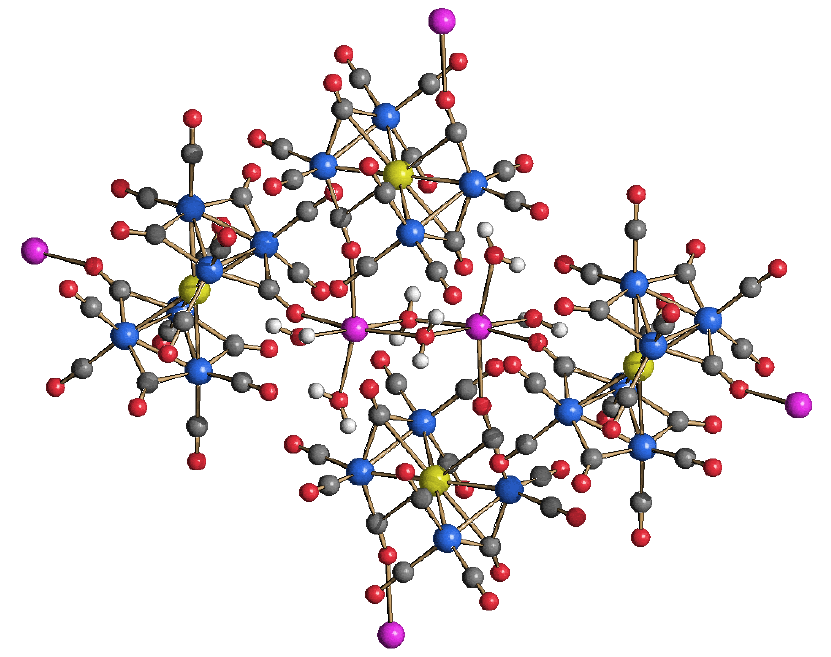
Figure 10. View of the Na + coordination and isocarbonyl linkages present in the crystal packing of Na 2 ( 7 )( 6 )·6H 2 O (yellow, Au; blue, Co; red, O; grey, C; white, H; purple, Na).